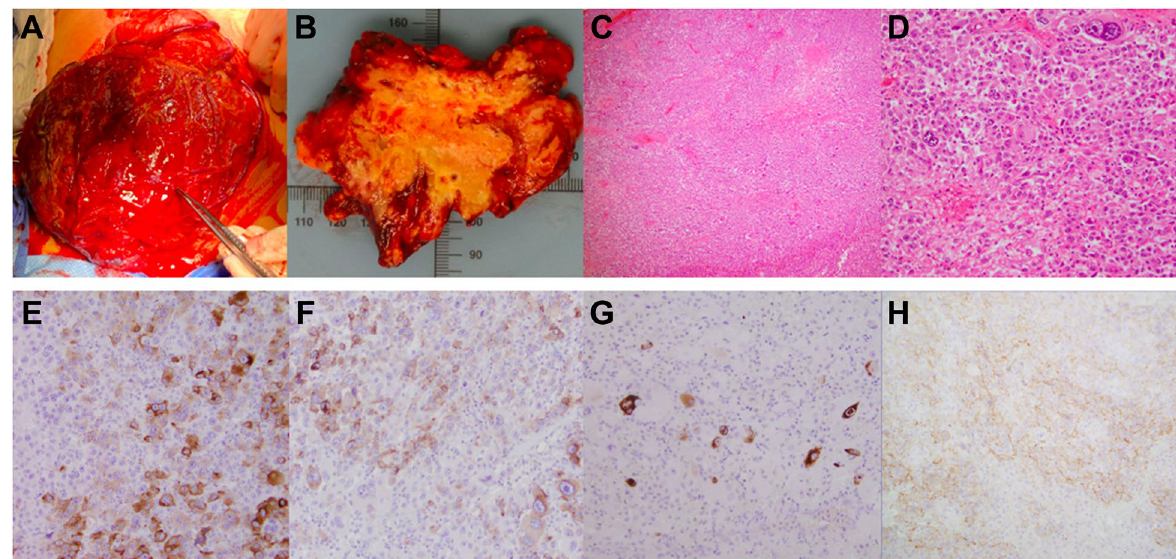
Fig. 1 Gross, light microscopic, and IHC findings. A Intra-operative gross photo of the tumor. B Representative section of tumor consisting of fleshy surfaces with extensive necrosis and hemorrhage. H & E stain showing sheets of malignant epithelioid cells with granular eosinophilic cytoplasm, marked nuclear atypia, and prominent nucleoli, 4x ( C ) and 20x ( D ). Tumor cells show patchy positive staining for Melan-A ( E ), HMB-45 ( F ), desmin ( G ), and CD117 ( H )